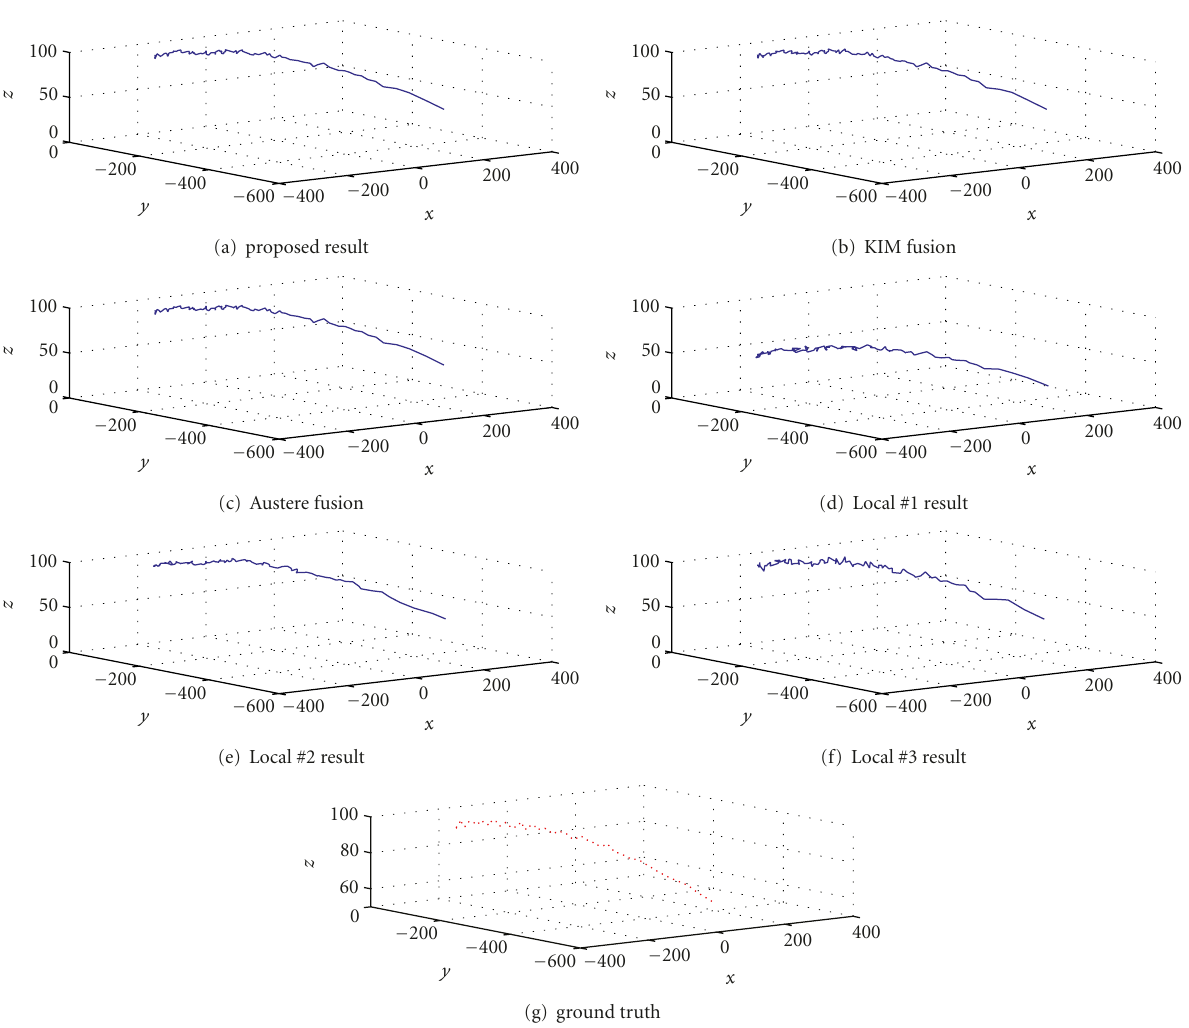
Figure 7: 3D tracking results for sequence 1. (a) Global estimate, (b) Kim’s fusion, (c) Austere’s fusion, (d)–(f) local estimates. (g) Ground